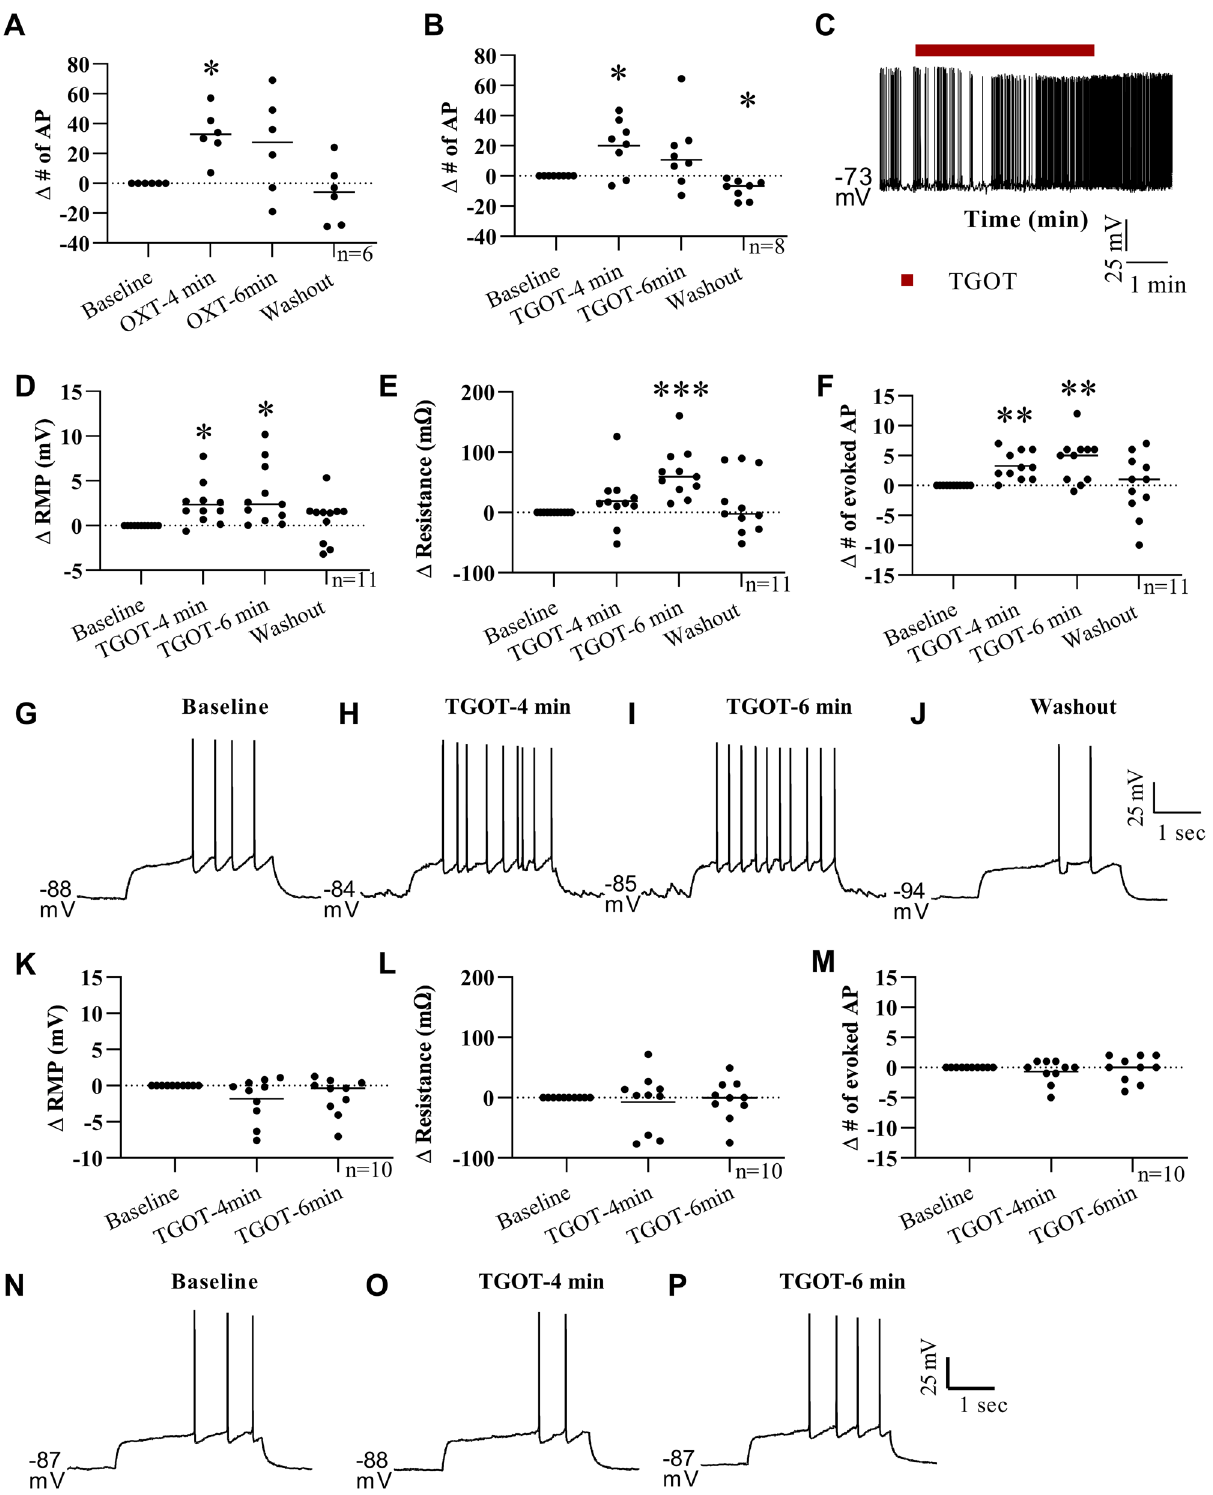
Figure 4. Oxytocin and TGOT have a depolarizing effect on EPN neurons. When held near the action potential threshold in current clamp recordings, bath application of OXT ( A , 200 nM) and TGOT ( B , 200 nM) elicited a significant increase in the number of spontaneous action potentials at 4 min after the start of application. Representative trace ( C ) shows increase in the spontaneous action potential firing after start of TGOT (red line) bath application which persists for several minutes. In a separate group of cells at their resting membrane potential, the membrane potential ( D ) was significantly depolarized with an increase in the number of evoked action potentials ( F ) at 4 and 6 min after the start of TGOT bath application. A significant increase in membrane resistance was detected only at the 6 min timepoint in this experiment ( E ). Representative traces from one neuron show the increase in evoked action potential firing at 4 and 6 min with a return to baseline levels during washout ( G – J ). In a separate experiment using OXTR-KO EGFP mice, TGOT bath application had no significant effect on the cells membrane potential, resistance or number of evoked action potentials ( K – M , representative traces in N – P ). *p < 0.05; **p < 0.005; ***p <